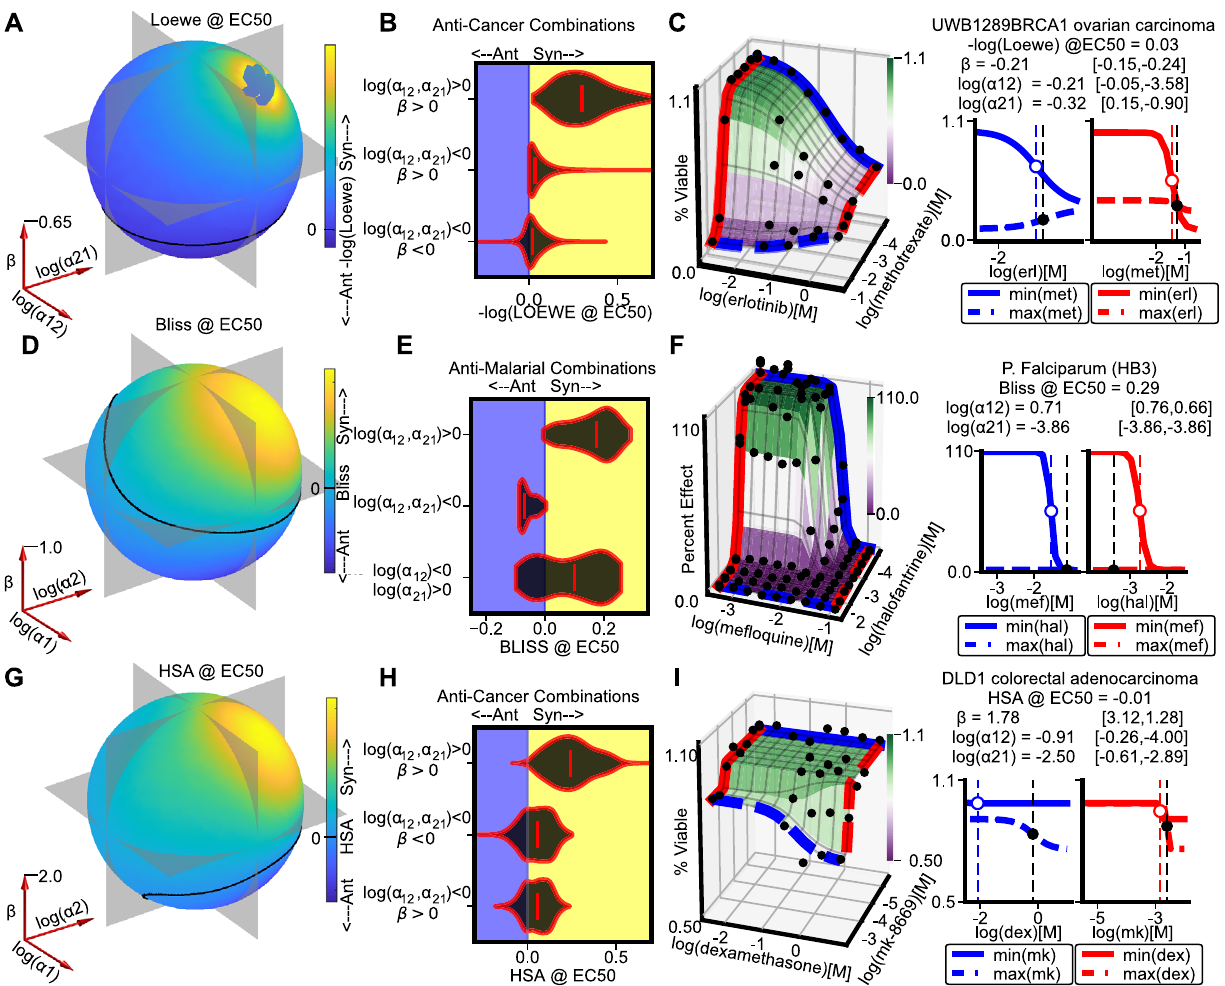
Fig. 3 Con fl ating potency and ef fi cacy synergy masks synergistic interactions in large drug combination datasets. A The colors on the sphere (radius on β axis bottom left) represent the value of Loewe (colorbar to right) for a drug combination with a MuSyC synergy pro fi le ( α α β ) (axes bottom left). 12 , 21 , and For all combinations: E 0 = 1, E 1 = E 2 = 0, h 1 = h 2 = 1, d 1 = d 2 = C 1 = C 2 , γ 12 = γ 21 = 1. The solid line marks the boundary between Loewe synergy and antagonism. Along this contour, which includes many different sets of ( α 12 , α 21 , and β ), Loewe is the same ( − log(Loewe) = 0). Gray planes correspond to β = 0, log ð α Þ ¼ 0, and log ð α Þ ¼ 0. The hole in the upper-right quadrant represents sets for which Loewe is unde fi ned. B Distribution of Loewe for anti- 12 21 cancer drug combinations 26 grouped by their synergy pro fi les according to MuSyC. Loewe was calculated as detailed in Methods section, including the Hill slope correction. The background color distinguishes antagonism (purple, “ Ant ” ) from synergism (yellow, “ Syn ” ). C The anti-cancer combination methotrexate and L-778123 26 is antagonistically potent and ef fi cacious against HT29 cells, by MuSyC; however, it is designated by Loewe to be synergistic. Left panel shows the MuSyC- fi tted dose-response surface, right panel shows the edges of the MuSyC surface. Color on the dose-response surface indicates effect (% Viable), with colorbar given next to the surface. On the right, the open circles mark the EC50 for each drug in isolation, closed circle is the shifted EC50 due to antagonistic potency. Brackets are 95% con fi dence intervals for each parameter based on Monte Carlo sampling (see Methods section). D Sphere for Bliss as in A . E Distribution of Bliss for anti-malarial drug combinations 25 . Combinations for which each drug alone achieves E max < 0.1 were selected, ensuring E 1 ⋅ E 2 ≈ E 3 ≈ 0. Under this condition, the differences between MuSyC and Bliss are due only to asymmetric potency synergy (all combinations near the β = 0 plane in D ). F Me fl oquine increases the potency of halofantrine (red curves) but halofantrine decreases the potency of me fl oquine (blue curves) in the HB3 strain of P. falciparum 25 . G Sphere for HSA as in A . H Distribution of HSA for anti-cancer combinations 26 grouped by MuSyC synergy pro fi le. In antagonistically potent combinations, HSA can miss synergistic ef fi cacy. I Combination of dexamethasone and mk-8669 in DLD1 cells 26 is anagonistically potent, but synergistically ef fi